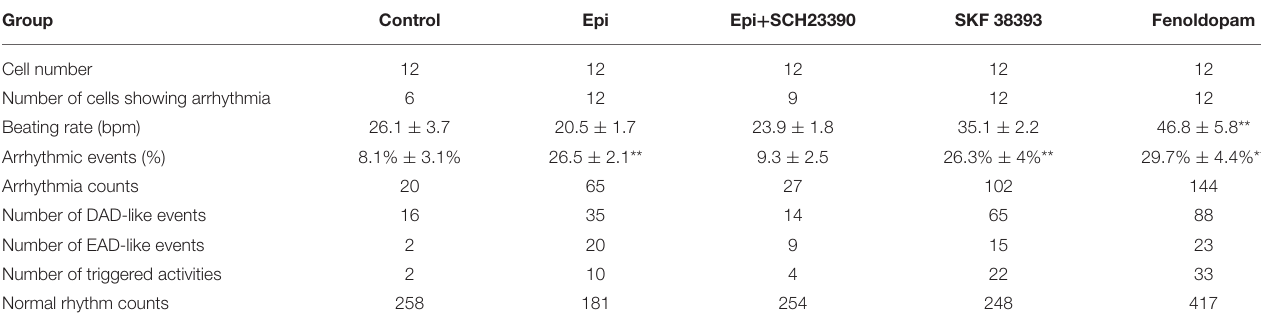
TABLE 1 | Analysis of arrhythmic events relating to dopamine receptors. Group